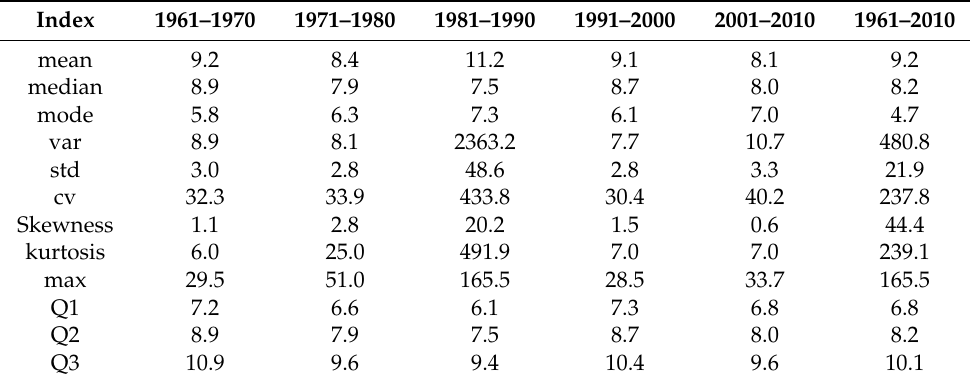
Table 1. Descriptive statistics of extreme precipitation thresholds in the northwest of Iran during different